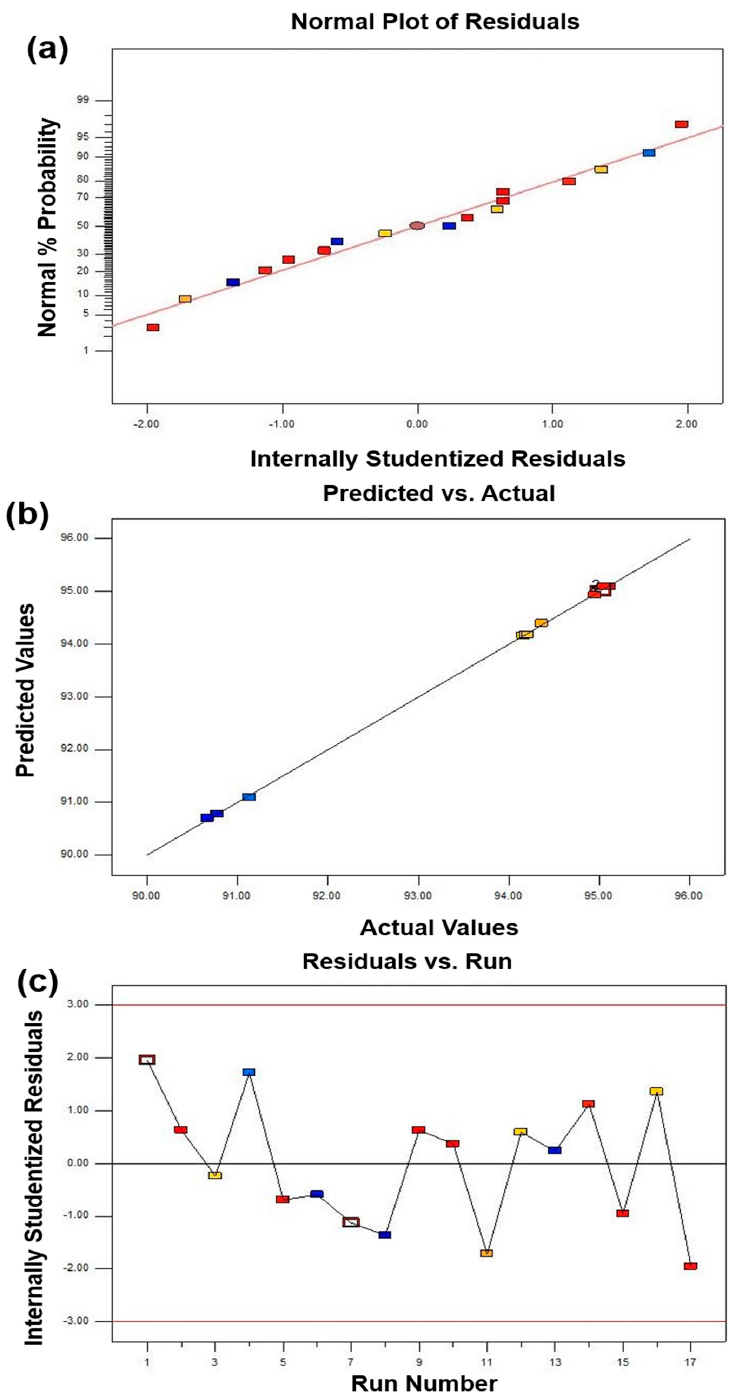
Figure 2. The adequacy of diagnostic maps of the relative density BBD model: ( a ) comparison of normal probability with internal studentized residuals, ( b ) comparison between actual and predicted values, and ( c ) internally studentized of each experimental point.